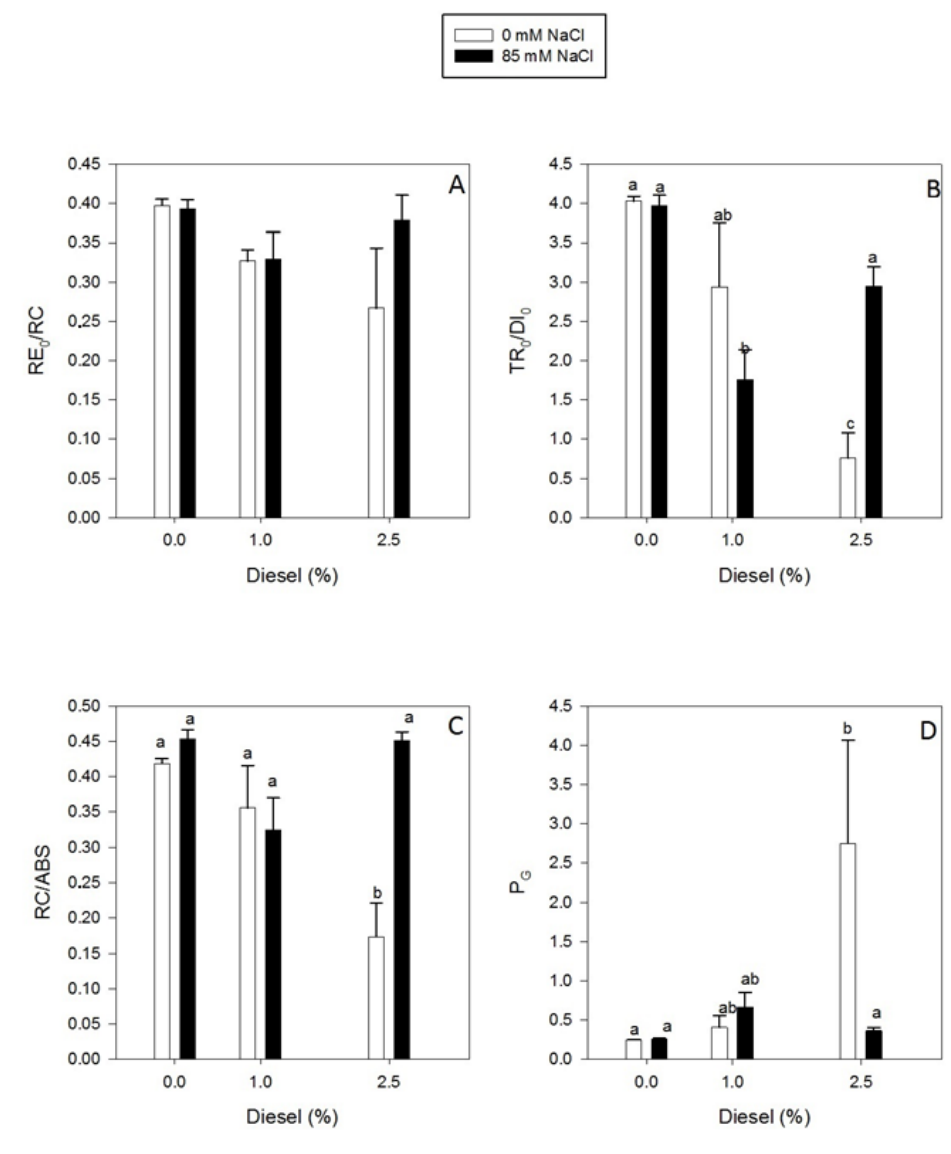
Figure 6. Electron transport flux until PSI acceptors per PSII, RE 0 /RC ( A ), flux ratio trapping per dissipation;, TR 0 /DI 0 ( B ), density of reaction centres on chlorophyll a basis, RC/ABS ( C ) and grouping probability, P G ( D ) per reaction center in dark-adapted randomly selected, primary branches of Juncus acutus in response to treatment with a range of diesel concentrations at 0 and 85.5 mM NaCl for 20 d. Values represent mean ± SE, n = 5. Different letters indicate means that are significantly different from each other (LSD, p <